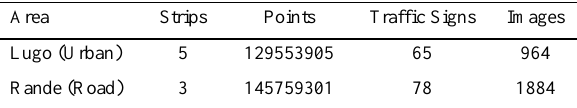
Figure 5. Case study. (a) Mobile Mapper System used for the survey. (b) Map of the surveyed